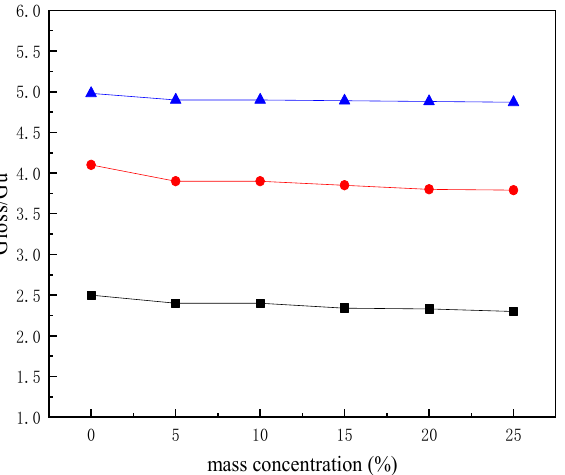
Figure 10. Gloss of the paper treated with different mass concentrations of polyurethane (chosen modes of G20, G60, and G75) ■ , G20; ● , G60; ▲ , G75.